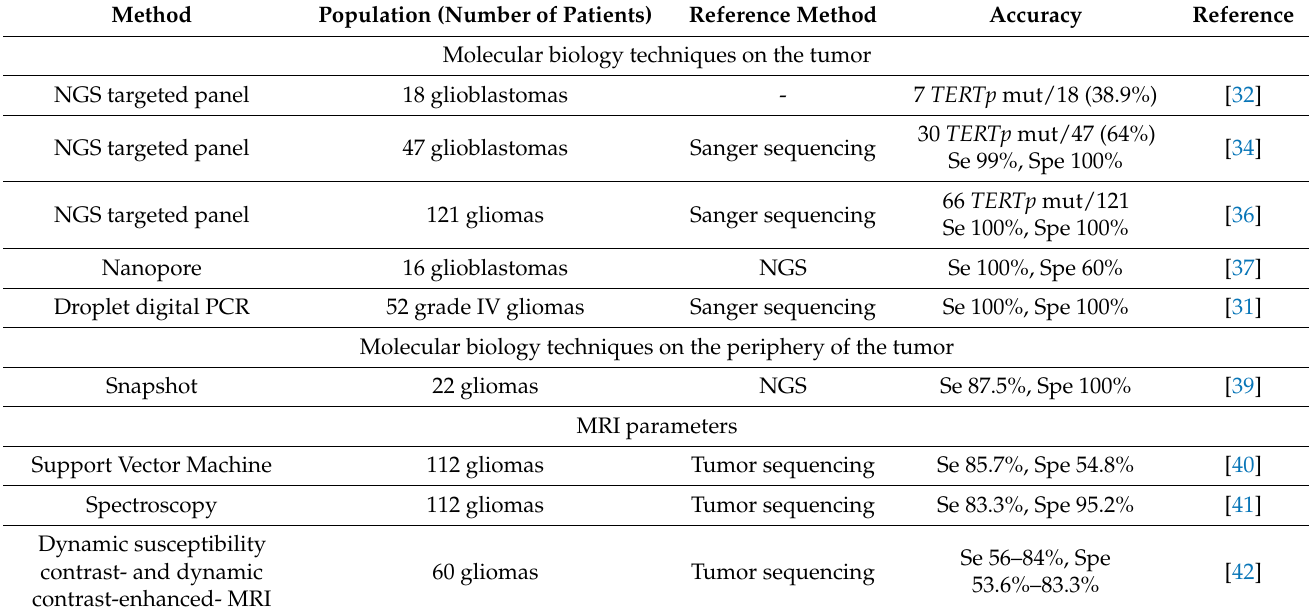
Table 1. Diagnostic performances of the different methods to detect TERTp